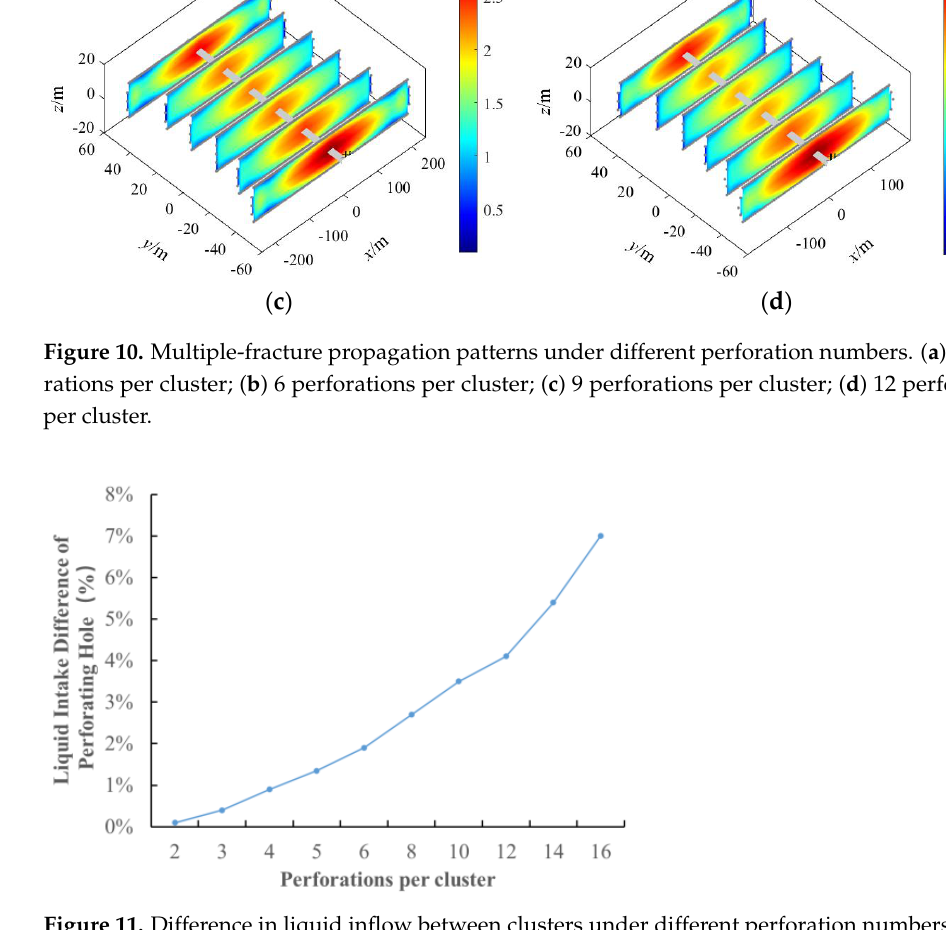
Figure 11. Difference in liquid inflow between clusters under different perforation numbers.